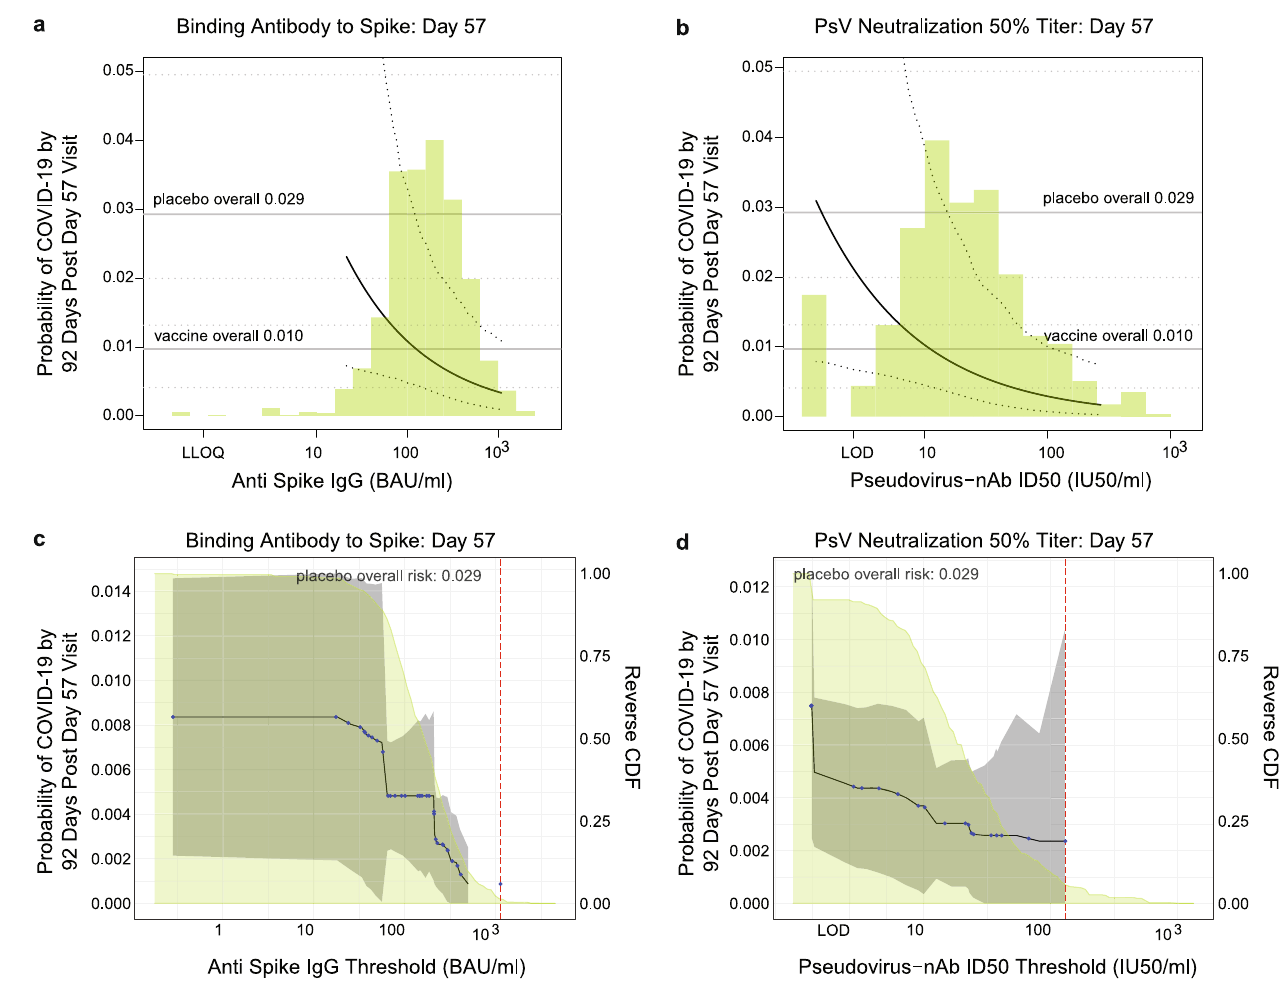
Fig. 4 Analyses of D57 antibody markers as a correlate of risk in baseline SARS-CoV-2 negative vaccine recipients. a , b Age and baseline risk score-adjusted cumulative incidence of COVID-19 by 92 days post D57 by D57 (A) anti-spike IgG or ( b ) pseudovirus (PsV)-nAb ID50 titer, estimated using a marginalized Cox model. The dotted black lines indicate bootstrap pointwise 95% CIs. The upper and lower horizontal gray lines are the overall cumulative incidence of COVID-19 from 7 to 92 days post D57 in placebo and vaccine recipients, respectively. Curves are plotted over the antibody marker range from the 2.5th percentile to the 97.5th percentile: 21.3 to 1088 BAU/ml for spike IgG and 1.31 to 270 IU50/ml for PsV-nAb ID50. c , d Age and baseline risk score-adjusted cumulative incidence of COVID-19 by 92 days post D57 by D57 ( c ) anti- spike IgG or ( d ) PsV-nAb ID50 titer above a threshold. The blue dots are point estimates at each COVID-19 primary endpoint linearly interpolated by solid black lines; the gray shaded area is pointwise 95% con fi dence intervals (CIs). The estimates and CIs assume a non- increasing threshold-response function. The upper boundary of the green shaded area is the estimate of the reverse cumulative distribution function (CDF) of D57 antibody marker level. The vertical red dashed line is the D57 antibody marker threshold above which no COVID-19 endpoints occurred (in the time frame of 7 days post D57 through to the data cut-off date March 5, 2021). PsV,